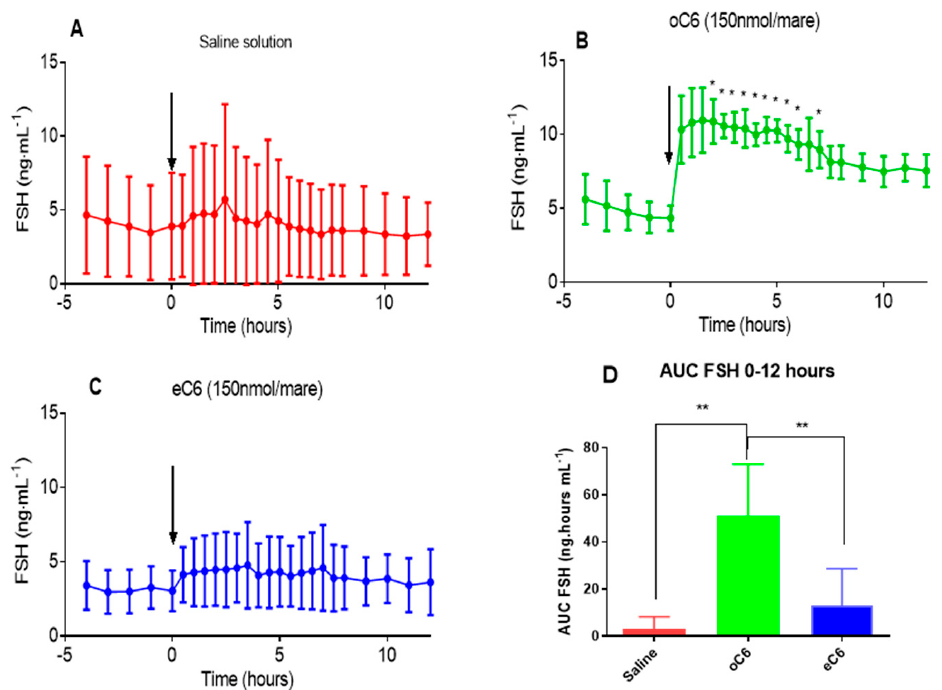
Figure 3. Effect of oC6 and eC6 on FSH secretion during the non-breeding season. During the non-breeding season an iv injection of 150 nmol/mare of either saline solution, oC6, or eC6 was delivered at time zero (arrow). Serial blood samples were taken from 4 h before to 12 h after injection and assessed for FSH content by ELISA. The time course showed that oC6 increases FSH plasma concentration compared to basal ( B ); F = 1.44, p = 0.001; stars on individual point indicate a significant difference from pre-treatment values), whereas eC6 ( C ); F = 1.47, p = 0.08) and saline solution ( A ); F = 1.36, p = 0.15) had no effect. The analysis of the area under the curve (AUC) showed that the total amount of FSH released after oC6 treatment is larger than after eC6 or saline solution treatments ( D ); F = 11.86, p = 0.008; * p ≤ 0.05, ** p ≤ 0.01). Data are expressed as mean ± SD. Statistical analysis was performed using ANOVA on repeated measure followed by Dunnett multiple comparisons test ( A – C ) or one way ANOVA followed by Tukey’s multiple comparisons test ( D